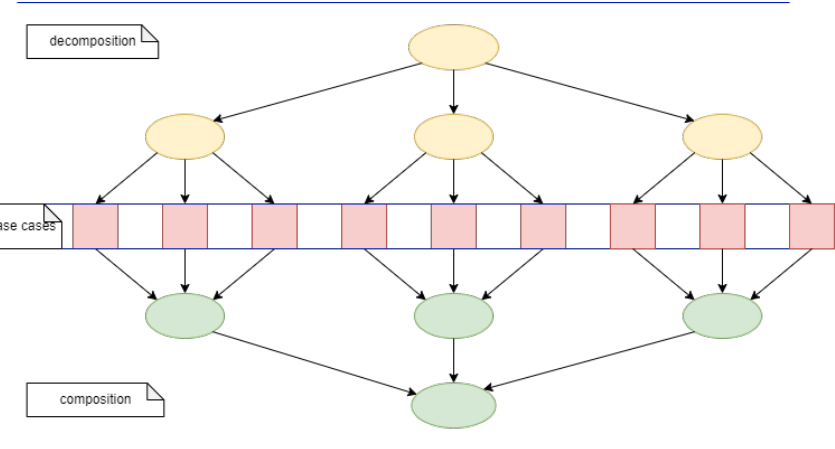
Figure 1. Task dependency graph of a divide-and-conquer computation with k equal to 3 and with the number of decomposition steps equal to